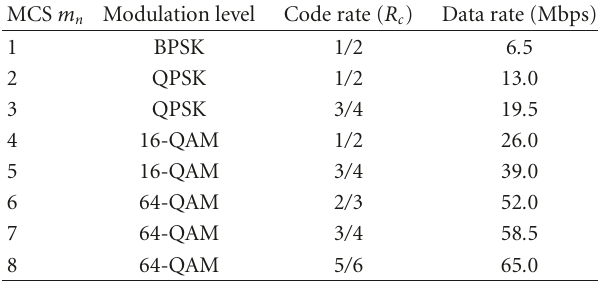
Table 1: Modulation and coding schemes of the IEEE 802 . 11n